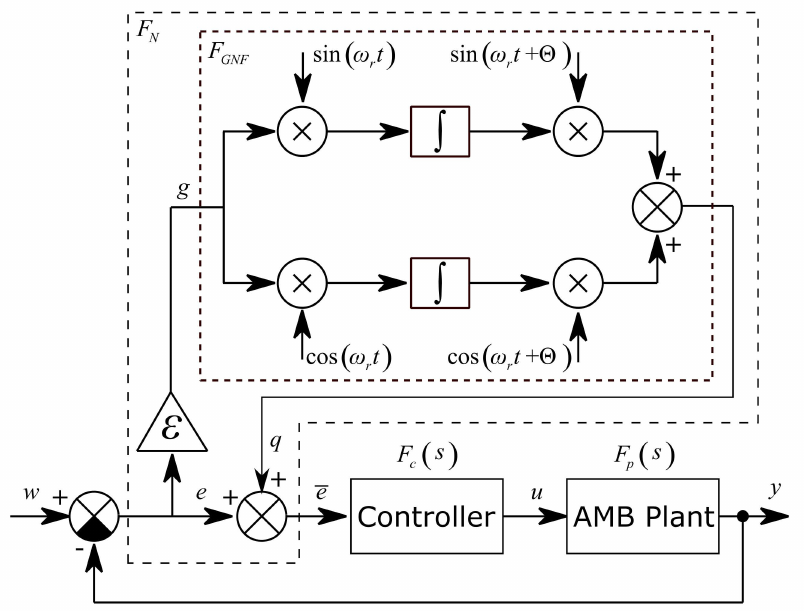
Figure 4. AMB closed loop control with the general notch filter as vibration